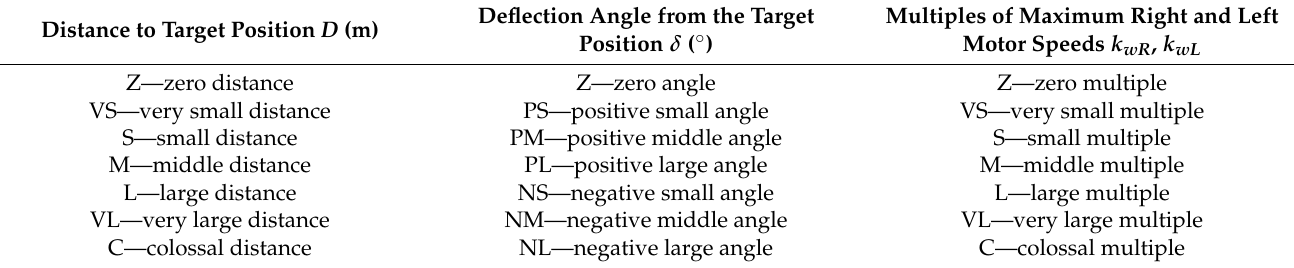
Table 1. Input and output linguistic values for D , δ , k wR , and k wL of fuzzy controller with 49 inference rules. Distance to Target Position D